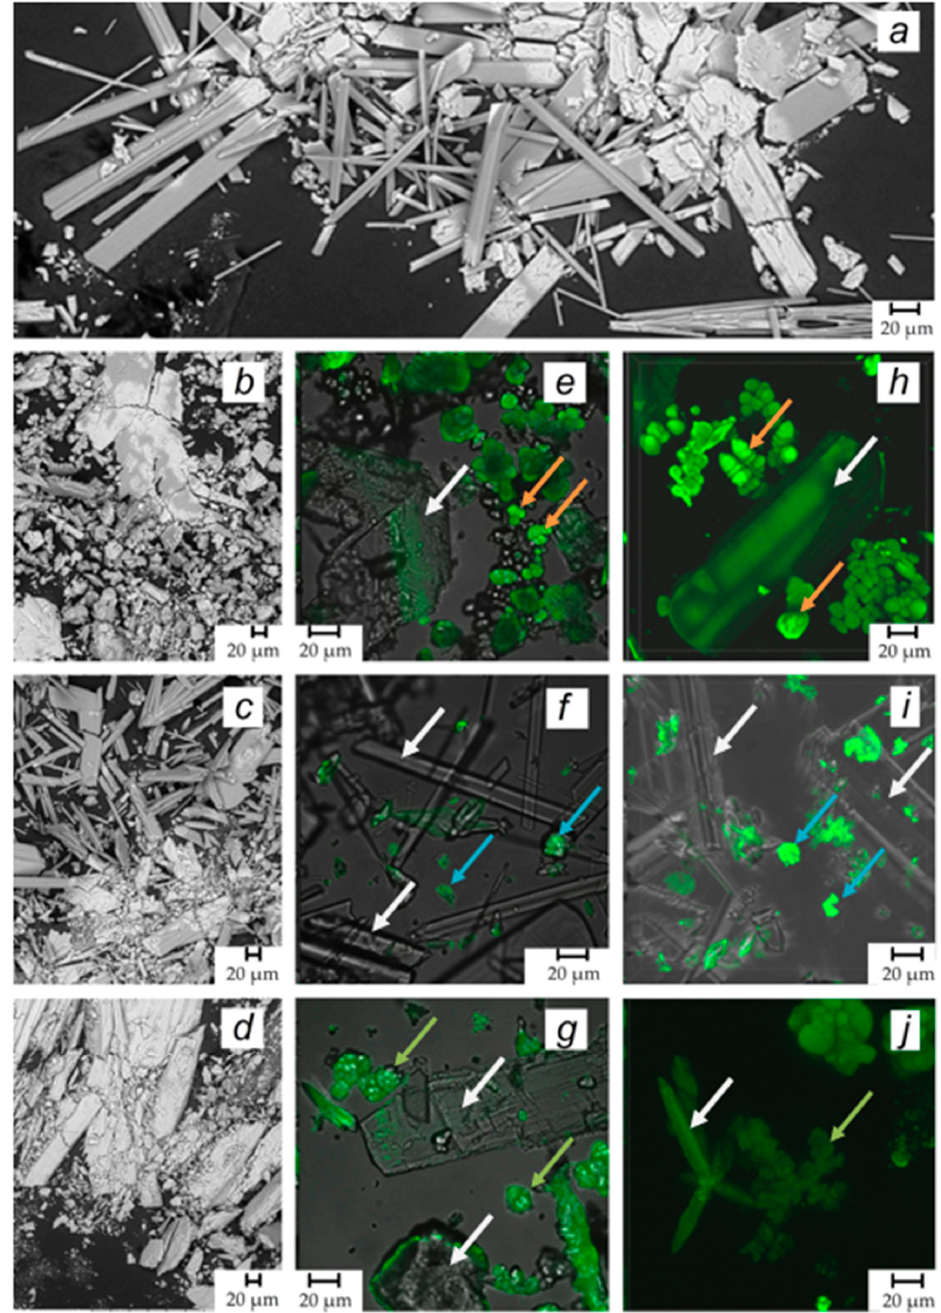
Figure 5. SEM ( a – d ), LSM 2D ( e – g ) and LSM 3D ( h – j ) images of gypsum, deposited after evaporation of an undersaturated aqueous solution at 70 °C in a blank run ( a ) and in presence of 10 mg·dm -3 ADMP-F ( b , e , h ), HEDP-F ( c , f , i ) and PAA-F1 ( d , g , j ); ( a – d , h – j ) images correspond to isolated solids, and ( e – g )—to aqueous solutions; red arrows indicate Ca-ADMP-F particles, blue arrows show Ca-HEDP-F species, green arrows indicate presumably Ca-PAA-F-1 phase, while white arrows—gypsum phase.